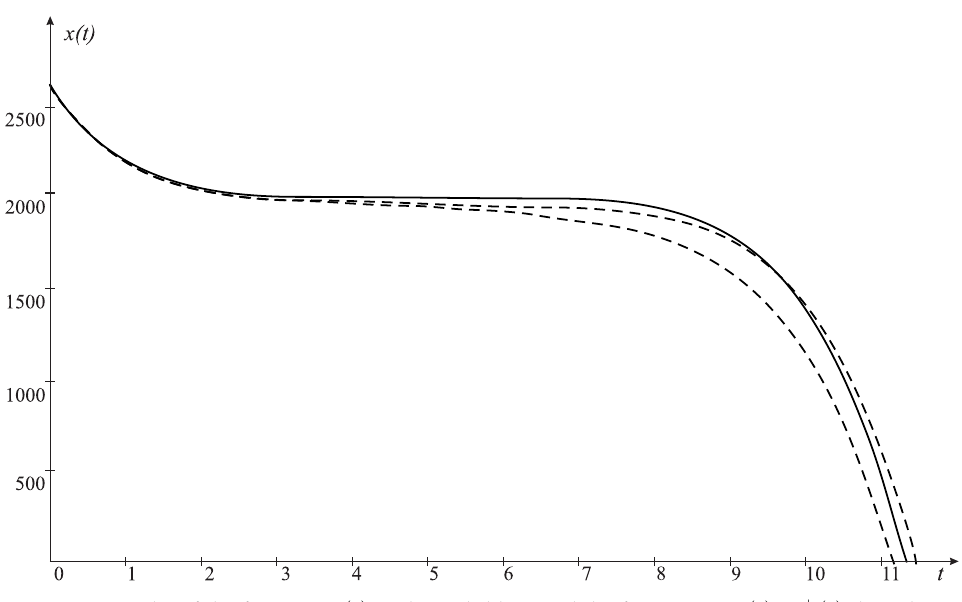
Figure 3. Graphs of the function x ( t ) with a solid line and the functions x − ( t ) , x + ( t ) dotted.